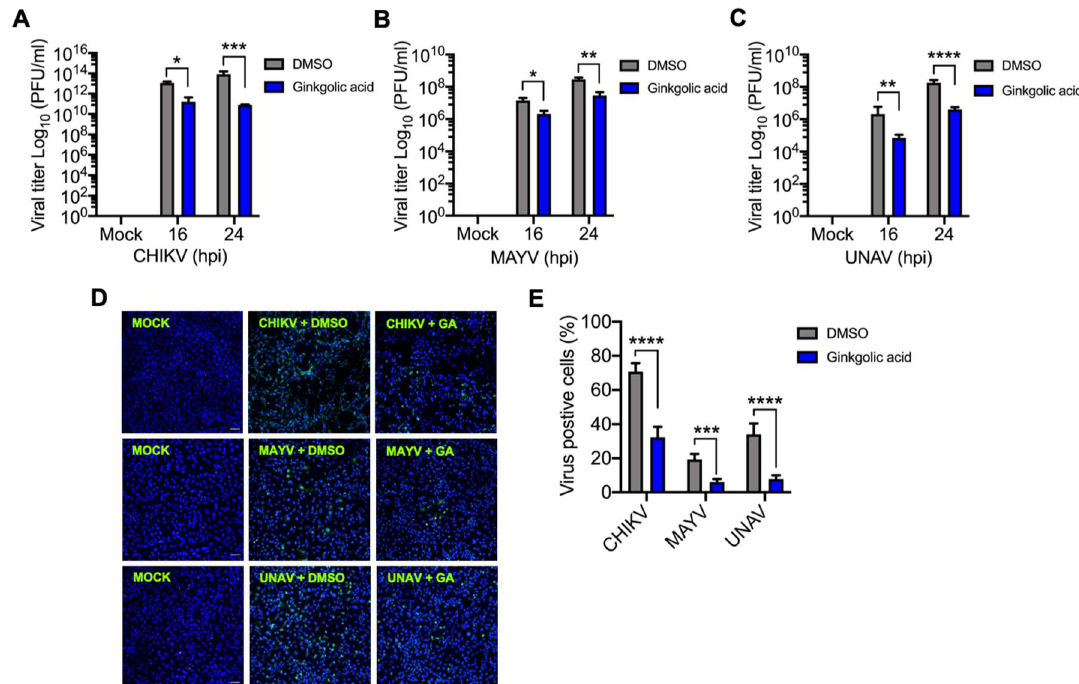
Figure 1. Ginkgolic acid impairs Alphavirus progeny production. Vero ( A ) and HeLa ( B , C ) cells were pre-treated with Ginkgolic acid at 10 µ M or 0.1% DMSO as a control for 1 h. Then, the medium with the treatment was removed and the cells were infected with CHIKV, MAYV or UNAV at an MOI of 10. After 1 h of virus absorption, fresh medium was added with Ginkgolic acid or DMSO and the cells were incubated for 16 or 24 h post-infection (hpi). Viral progeny yield in cell supernatants collected at indicated times were quantified by plaque-forming assay. Viral titers were represented as plaque-forming units per milliliter (PFU / mL). Statistically significant di ff erences were assessed with the Two-way ANOVA test: * p < 0.05; ** p < 0.01; *** p < 0.001 and **** p < 0.0001. ( D,E ) Vero or Hela cells grown on glass cover slips were pre-treated with Ginkgolic acid or DMSO and then infected with the Alphavirus at an MOI of 1. After 24 h of incubation with the treatment, cells were fixed and stained with anti-CHIKV, anti-MAYV or anti-UNAV mouse primary antibodies, followed by an Alexa-Flour 488 mouse secondary antibody. Cell nuclei were stained with Dapi (in blue). Images were obtained with a confocal microscope and analyzed with ImageJ software. The percentage of viral antigen-positive cells was evaluated in at least 10 fields for each experimental condition. These data were analyzed with the Two-way ANOVA test. Statistically significant di ff erences are shown: *** p < 0.001 and **** p < 0.0001. Scale bar, 50 µ